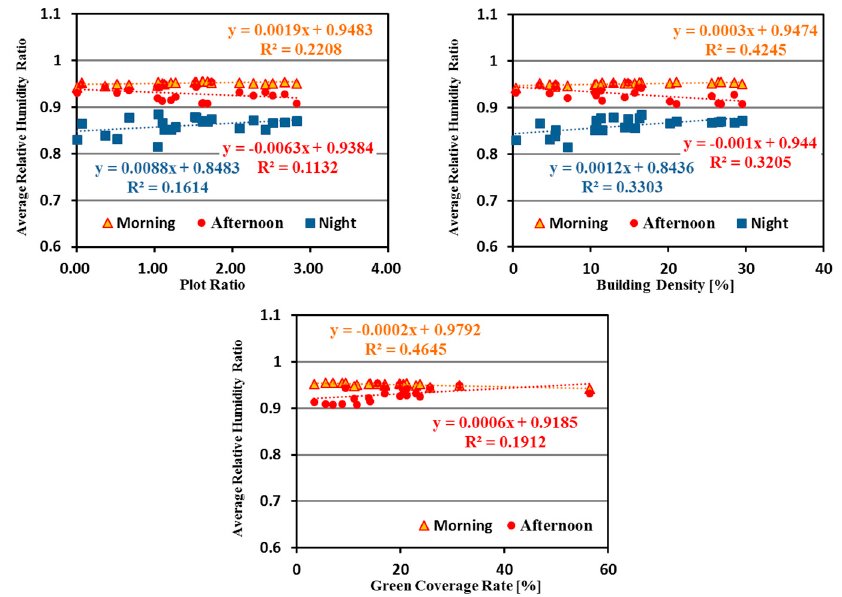
Figure 11. Relationships between the urban morphology index ( x -axis) and relative humidity ratio from the mobile and reference point ( y -axis) measurements in the commercial district.